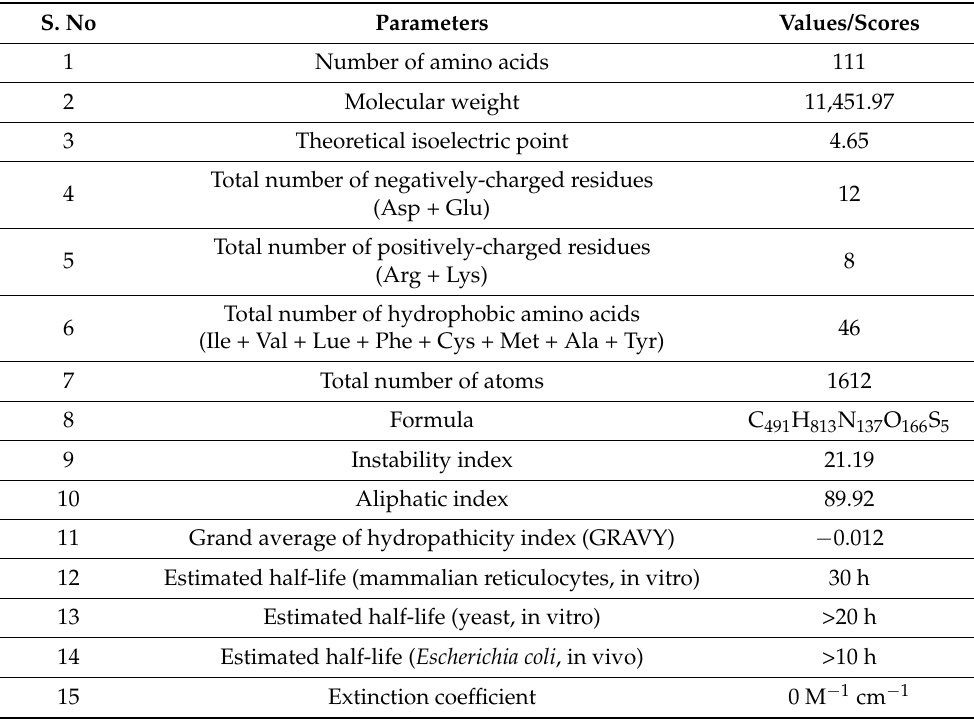
Table 1. List of physiochemical properties of Bg_9562 protein using ProtParam